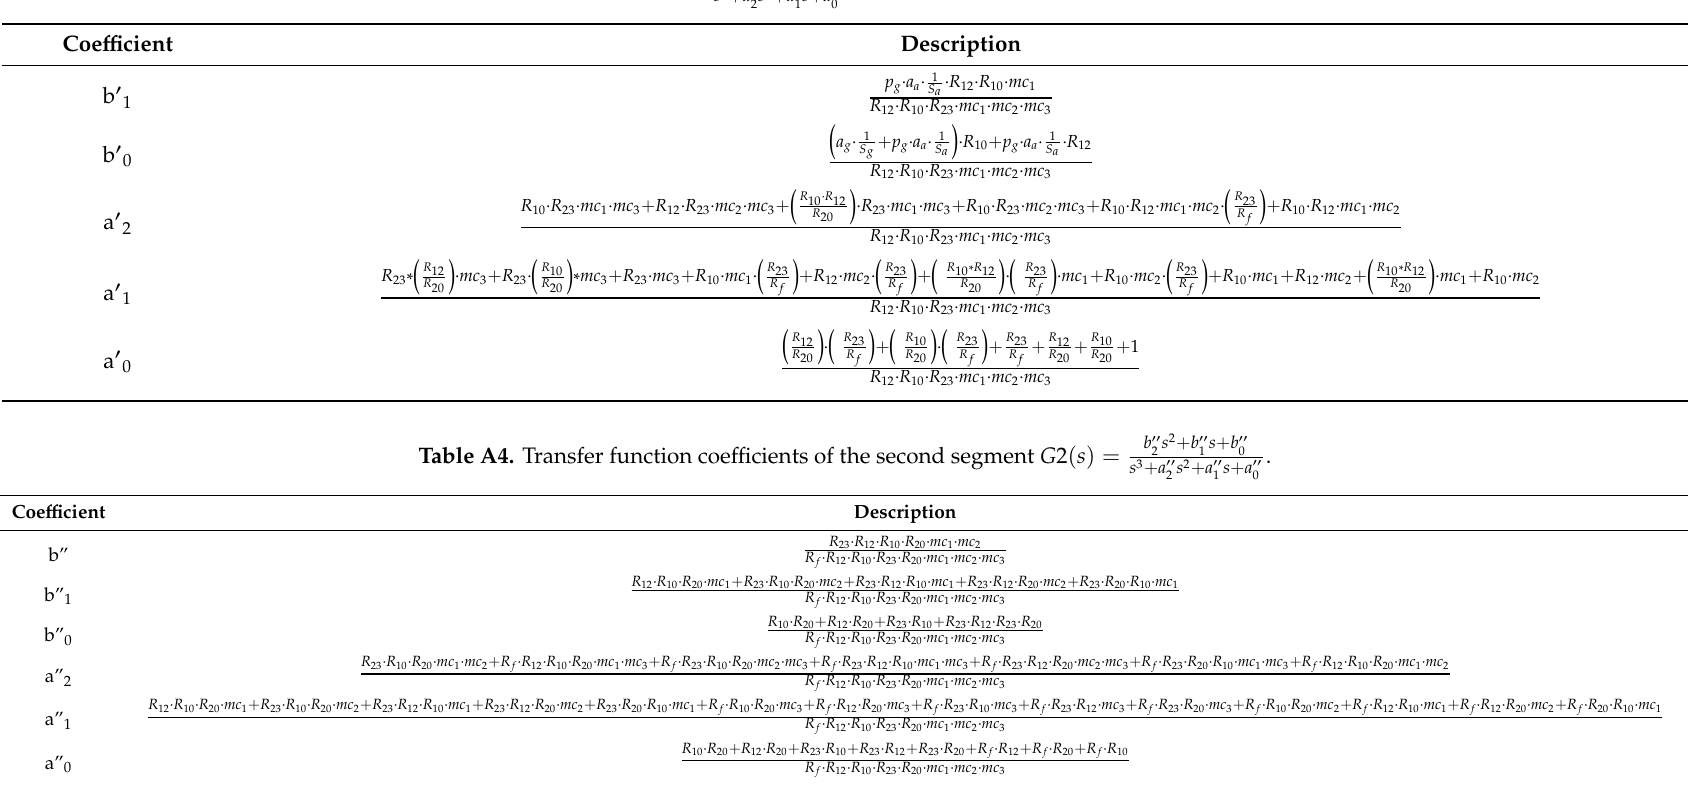
Table A3. Transfer function coe ffi cients of the first segment G 1 ( s ) =